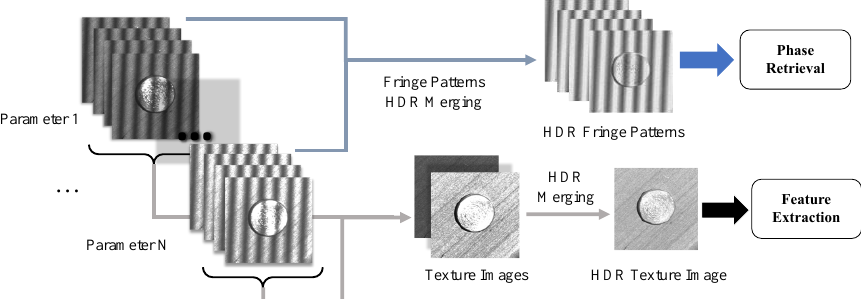
Figure 2. Principle of HDR measurement. Sets of images are recorded under different exposure times and projected intensities. Texture images and fringe pattern images are separately merged to achieve HDR measurement. The HDR patterns are then used for phase retrieval while HDR textures for feature extraction.